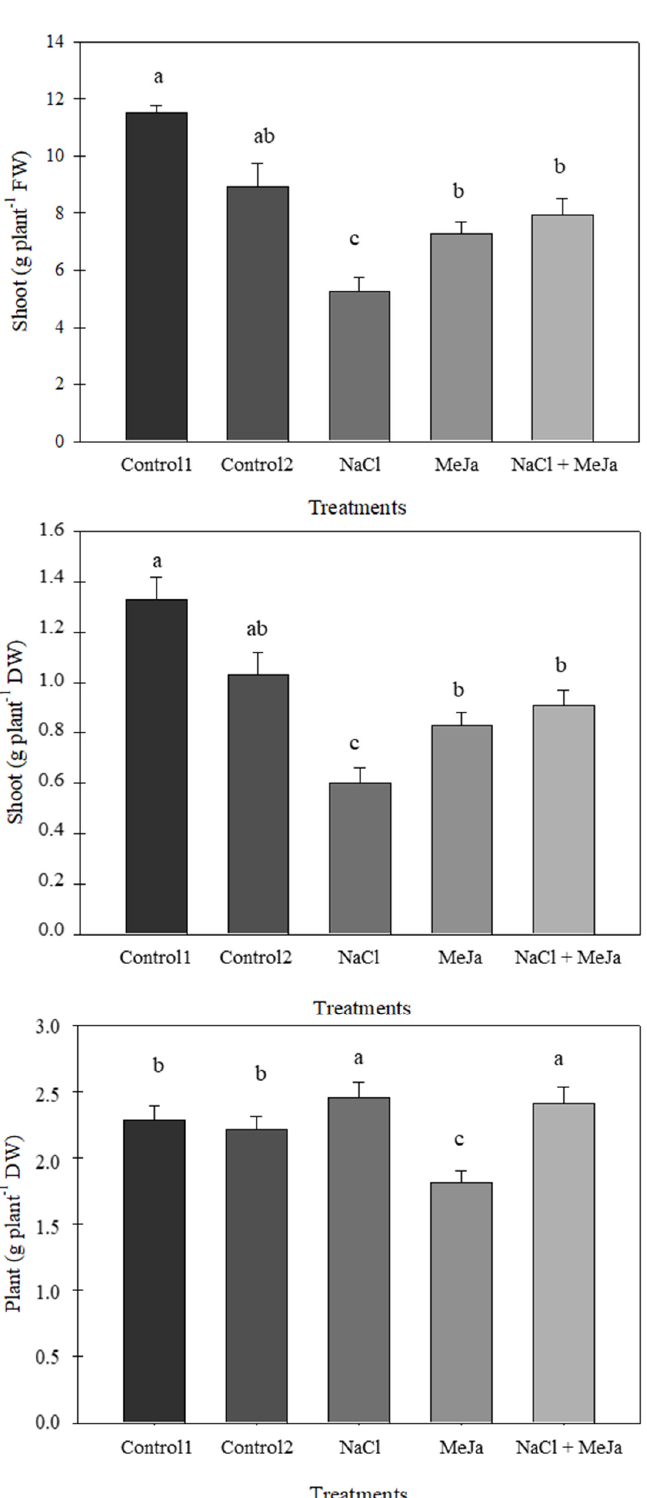
Figure 1. Fresh weight (FW) and dry weight (DW) of the aerial part of C. maritimum plants, and DW (gr plant − 1 ) of the whole plant, grown under hydroponic conditions with the following treatments: Control1, Control2, NaCl, MeJa, NaCl + MeJa, ( n = 20). Different letters (a, b, c) indicate significant differences according to Tukey’s test ( p < 0.05).